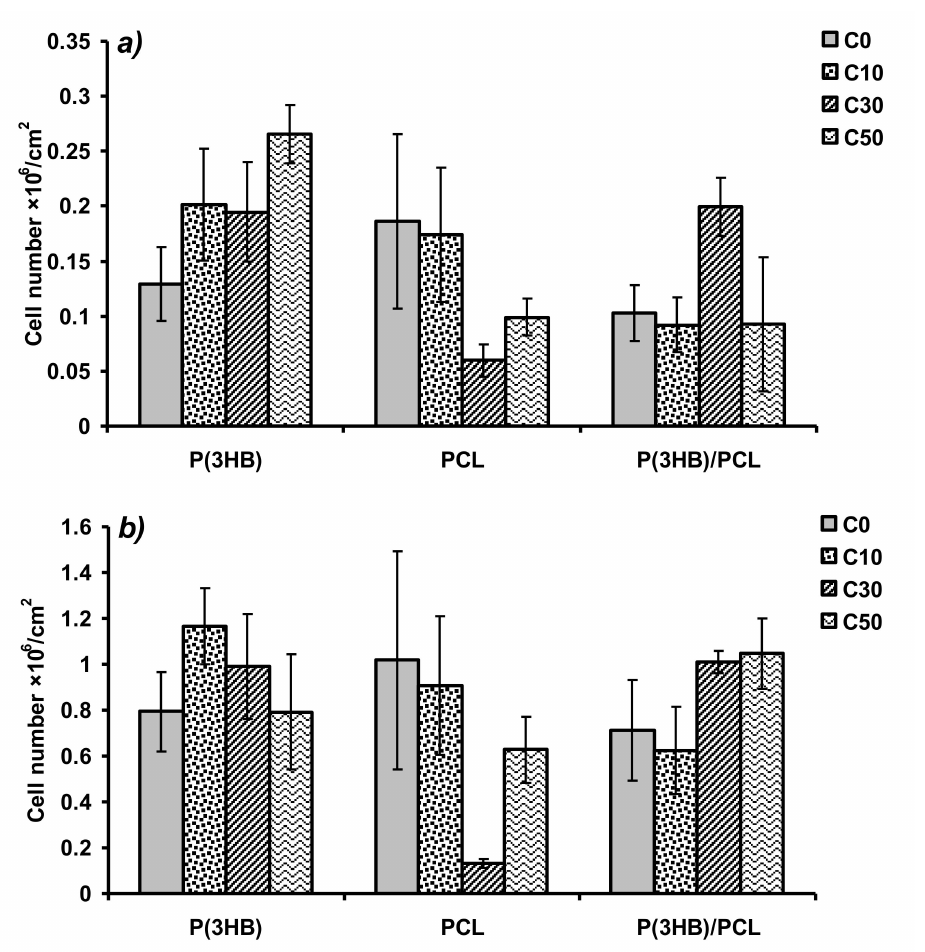
Figure 3. Results of MTT assay—the number of viable NIH 3T3 mouse fibroblast cells on polymer films at Days 3 ( a ) and 7 ( b ) of